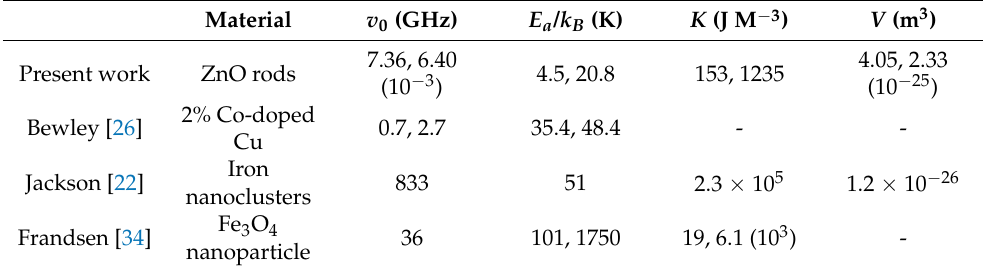
Table 2. Comparison of superparamagnetic cluster constants, for samples 1 and 2, respectively, from this work with other published